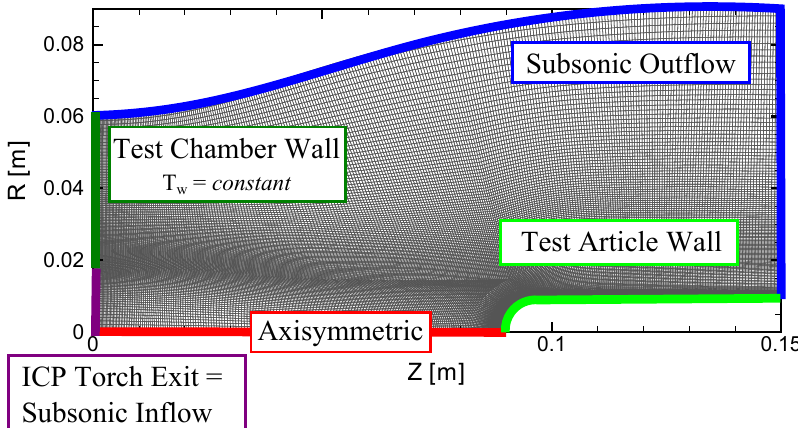
Figure 3. Computational domain and boundary